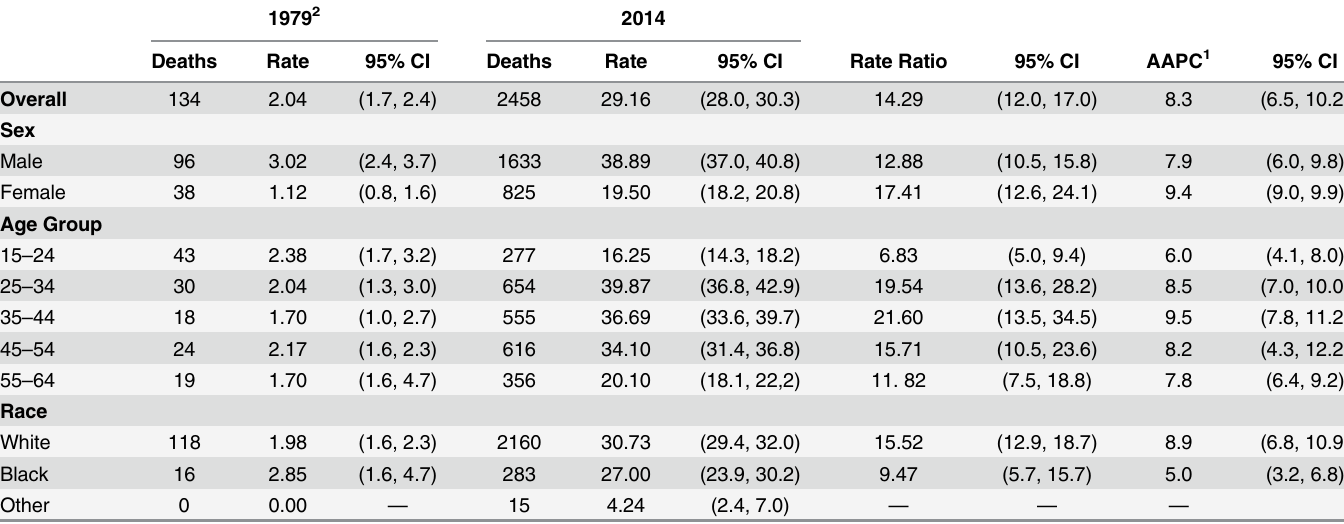
Table 1. Counts and crude rates per 100,000 of accidental poisoning deaths among persons age 15 to 64, by selected